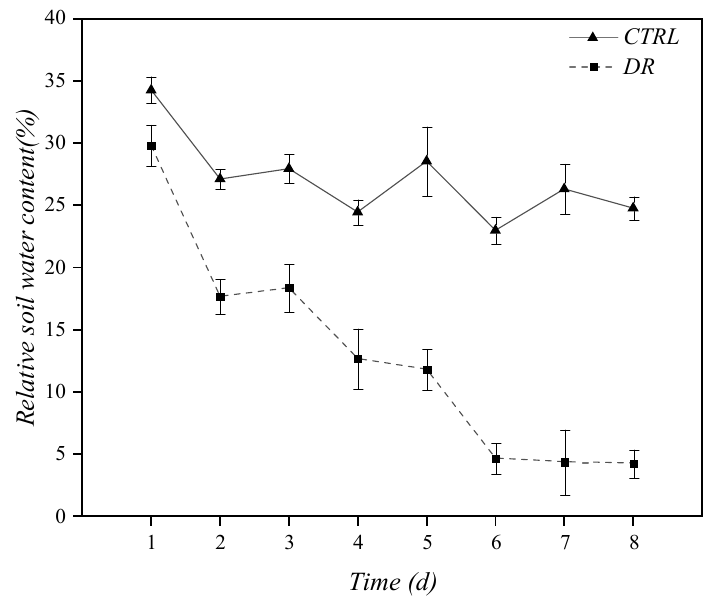
Figure 1. The change in the relative water content of the soil during the experiment period (Day 1–Day 8), i.e., control (CTRL), drought (DR).